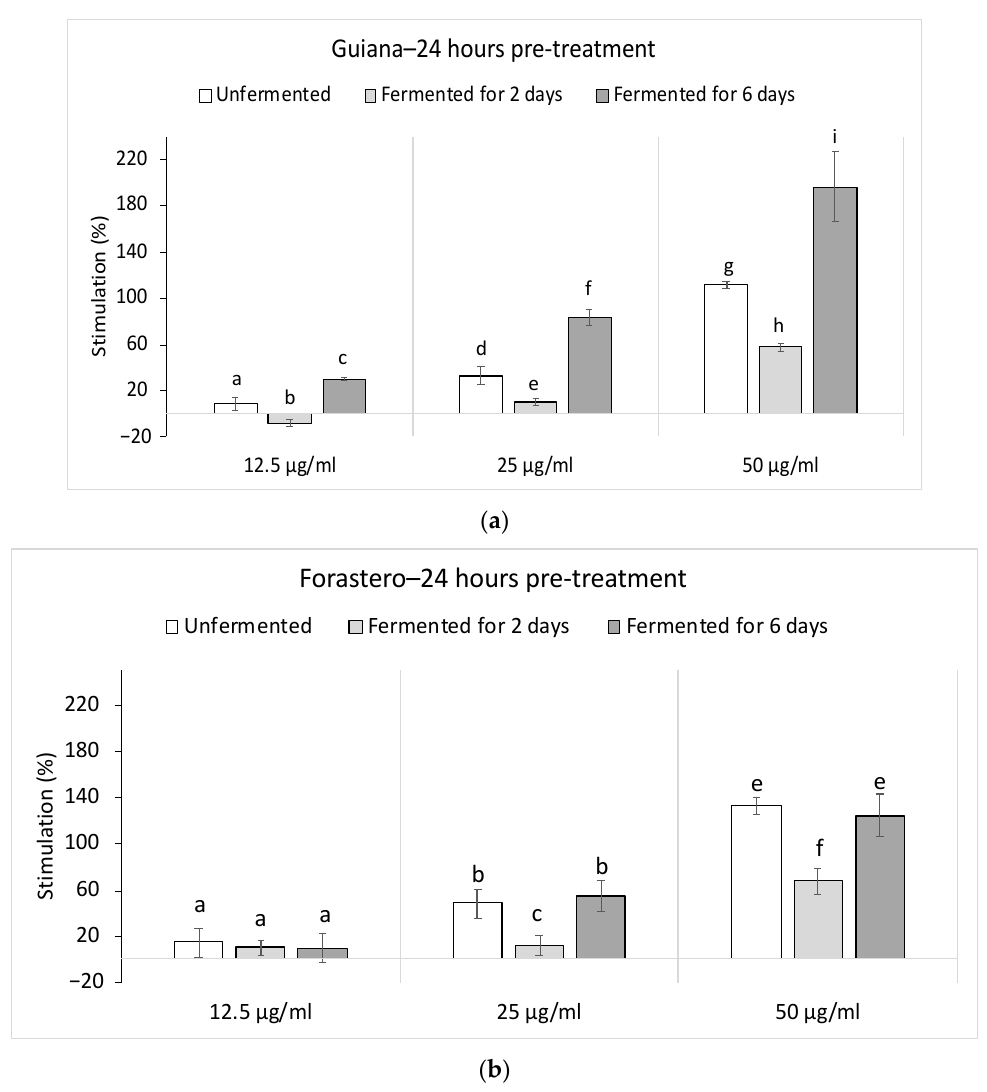
Figure 4. Stimulation rates of both varieties on tumor necrosis factor alpha (TNF- α) production in lipopolysaccharide (LPS) and interferon gamma (IFNγ )-stimulated macrophages. ( a ) Guiana, ( b ) Forastero. Results represent the mean % stimulation of TNF- α production ± SEM ( n = 4). At each concentration, histograms with the same letter a–i for ( a ) or ( b ) were not significantly different ( p < 0.05) using a Mann–Whitney U test.